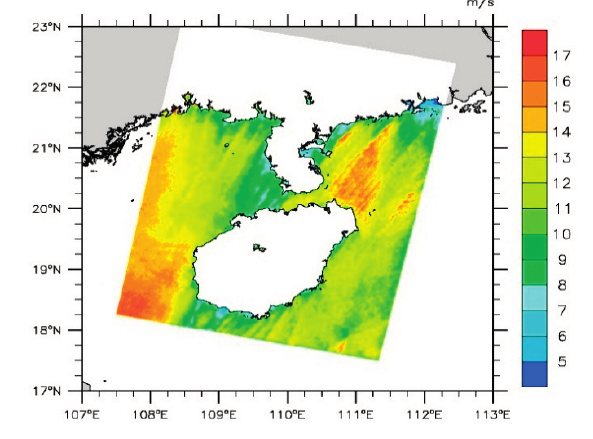
Figure 4. Spatial averaging wind field retrieved from ENVISAT ASAR WSM data for 2 November 2009 at 02:36